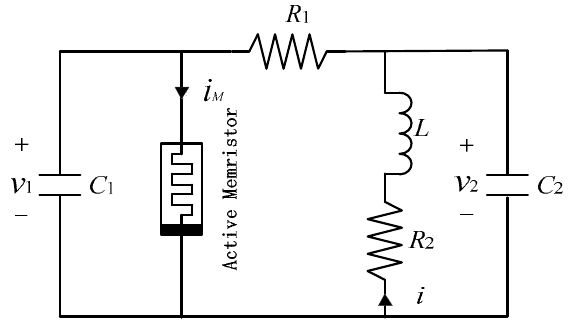
Figure 5. Memristor-based chaotic circuit.